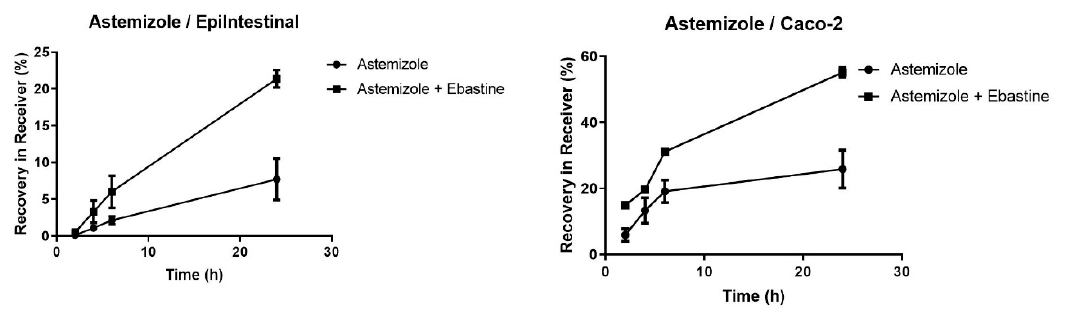
Figure 2. Apical-to-basal transport of astemizole in EpiIntestinal microtissues and Caco-2 cells. Astemizole (10 µ M) was added to the apical compartment of EpiIntestinal microtissues ( left ) or Caco-2 cells ( right ) grown on Transwell inserts and incubated at 37 ◦ C. At the indicated timepoints, samples were taken from the basal (receiver) compartment. Astemizole was quantified in the samples via HPLC-MS / MS. The incubation was carried out in the absence or in the presence of the competitive CYP2J2 inhibitor Ebastine (50 µ M). Data are shown as mean values of triplicates. Error bars show standard deviations.